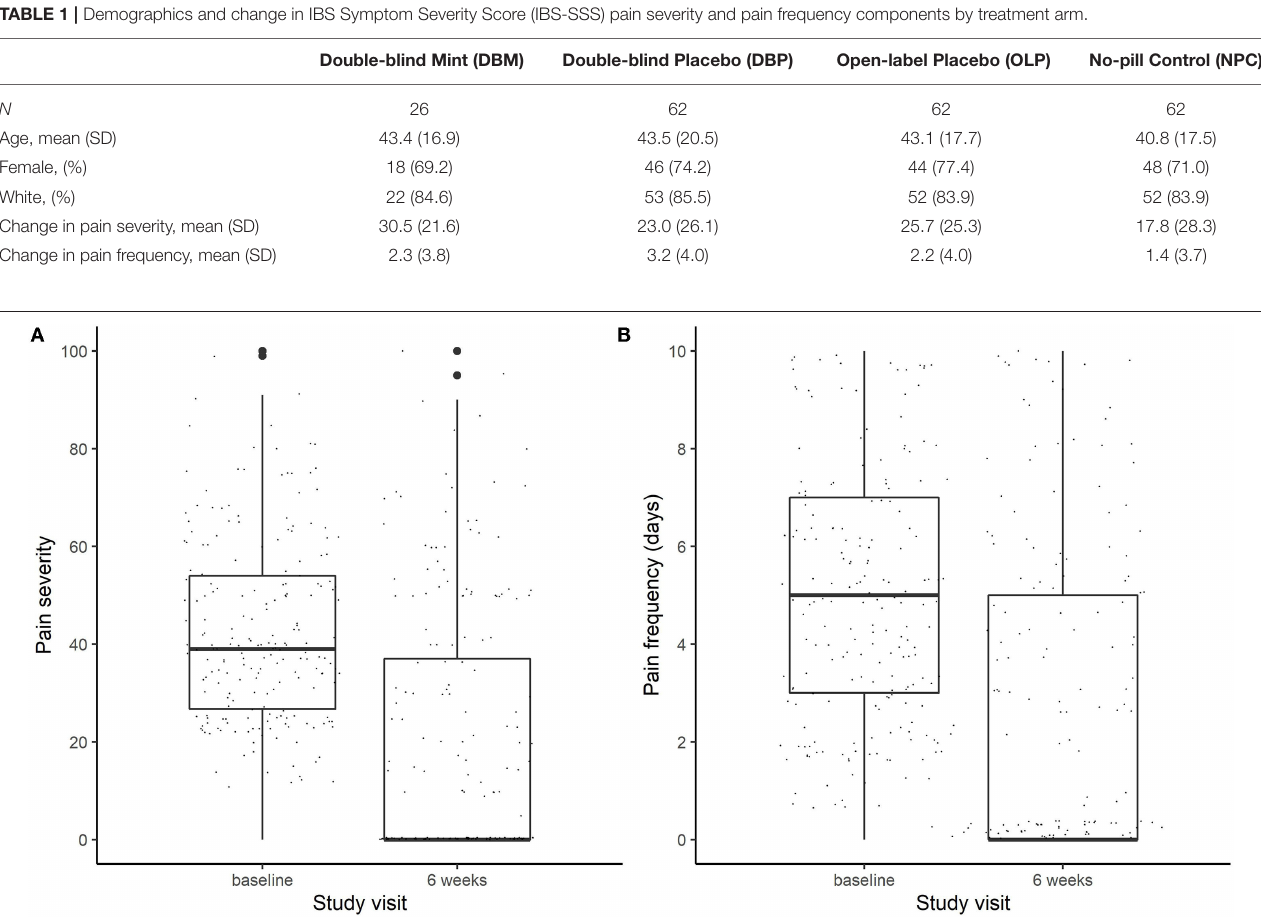
FIGURE 1 | Boxplots of (A) pain severity (on a scale of 0–100) and (B) Pain frequency (measured in days out of the last 10 days) at baseline and at the end of the trial (week